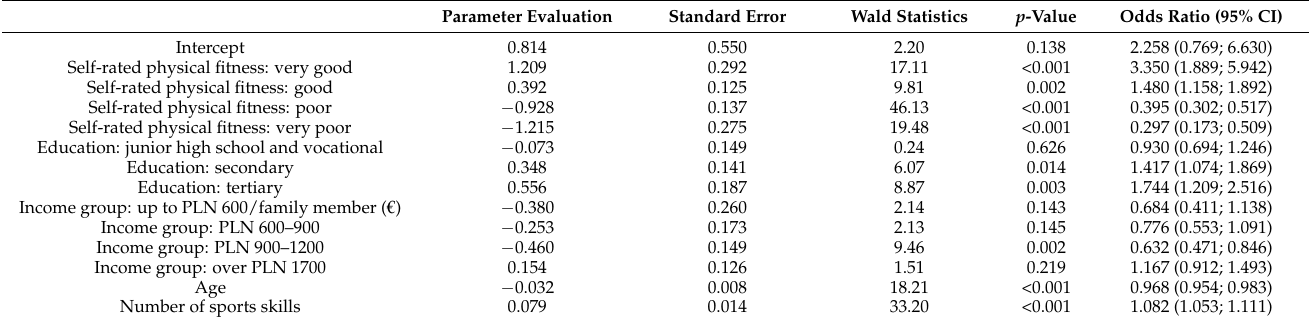
Table 2. Results of multiple logistic regression